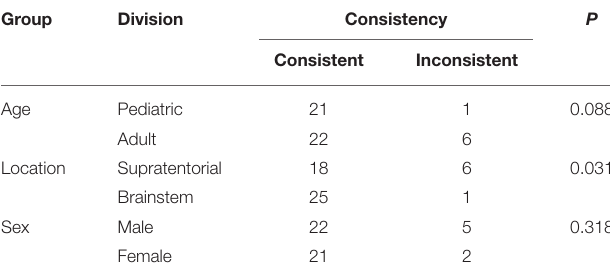
TABLE 2 | Consistency between fluorescein and neuronavigation. Group